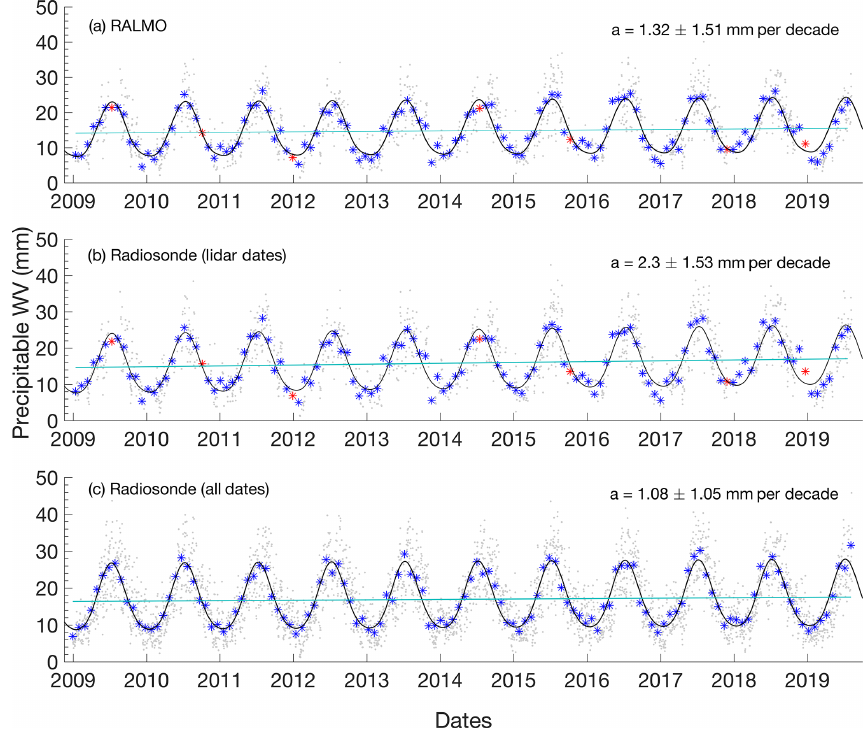
Figure 8. The nighttime precipitable water vapour measurements taken by RALMO and the daily radiosondes. For all subplots, the nightly measurements are the grey dots, 30d averages are the blue stars with interpolated points in red, the fitted function is in black, and the trend line is in light blue. (a) RALMO PWV measurements, (b) radiosonde PWV measurements on coincident dates with lidar measurements, (c) radiosonde PWV measurements for all available dates. Table 1. Table of precipitable water vapour trends calculated using RALMO and daily radiosonde monthly averaged measurements from January 2009 to August 2019. Trends are presented in units of millimetre per decade (mm per decade), per cent change from the mean per decade (% per decade), and per cent change in water vapour per degree Celsius (% ◦ C − 1 ). The trend values in column 3 were calculated by dividing the water vapour trend in column 2 by the surface temperature trend of 1 . 38 ± 1 . 41 ◦ C per decade. Trend uncertainties are 2 σ a values, in units of millimetres per decade, and are calculated using Eq. (5). Measurement series Trend Trend Trend Trend